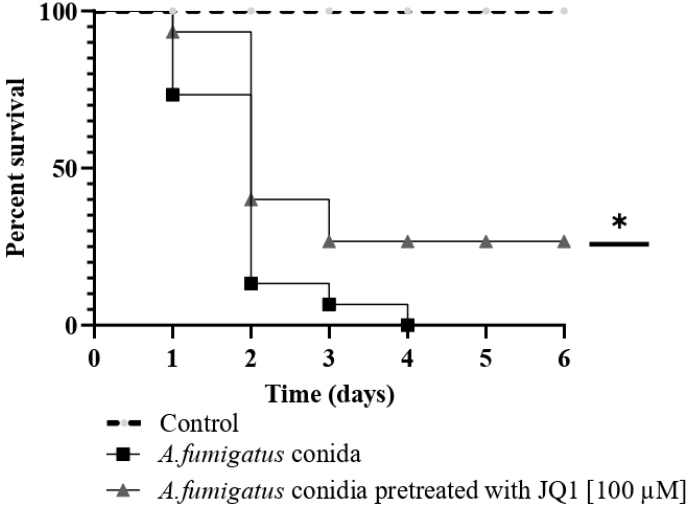
Figure 9. The mortality of G. mellonella following injection with conidia obtained from A. fumigatus treated with JQ1or not. G. mellonella survival curves. Larvae (n = 15/strain) were infected with conidia (10 4 conidia/larvae) from A. fumigatus grown with or without JQ1. Larvae were monitored daily for 6 days post-infection. Statistically significance compared to control was assessed by the Kaplan–Meier followed by Mantel–Cox log-rank test. Three experiments on different dates were performed. * p < 0.05 .